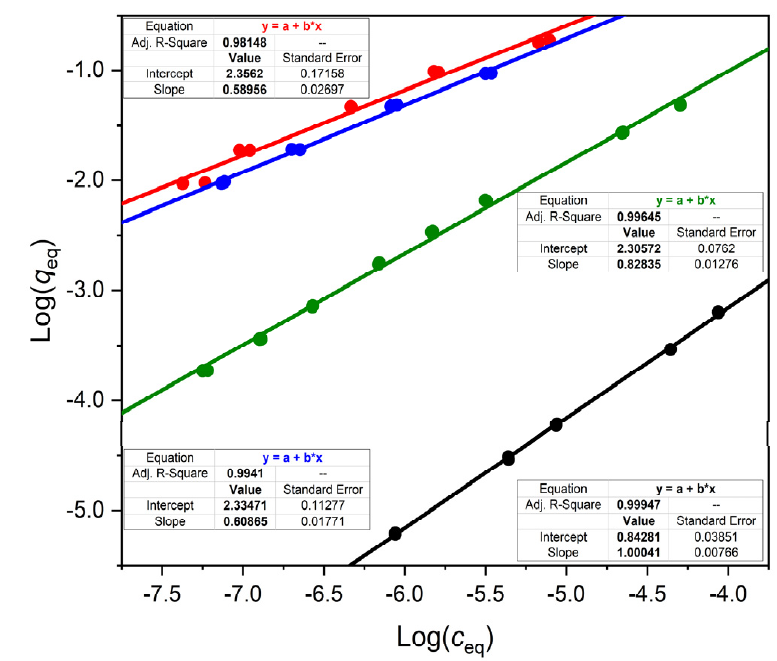
Figure 2. Comparison of ketoprofen isotherms under different adsorption conditions. All isotherms were measured in 20% methanolic buffer. The isotherms on OASIS ® HLB were measured at pH 3.2 (red), pH 4.3 (blue), and pH 7.0 (green), respectively. The ketoprofen isotherm on DSC-18 (a conventional C18 sorbent) was measured at pH 7.0 ( black ). Linear equations are shown in the figure with the corresponding colors.